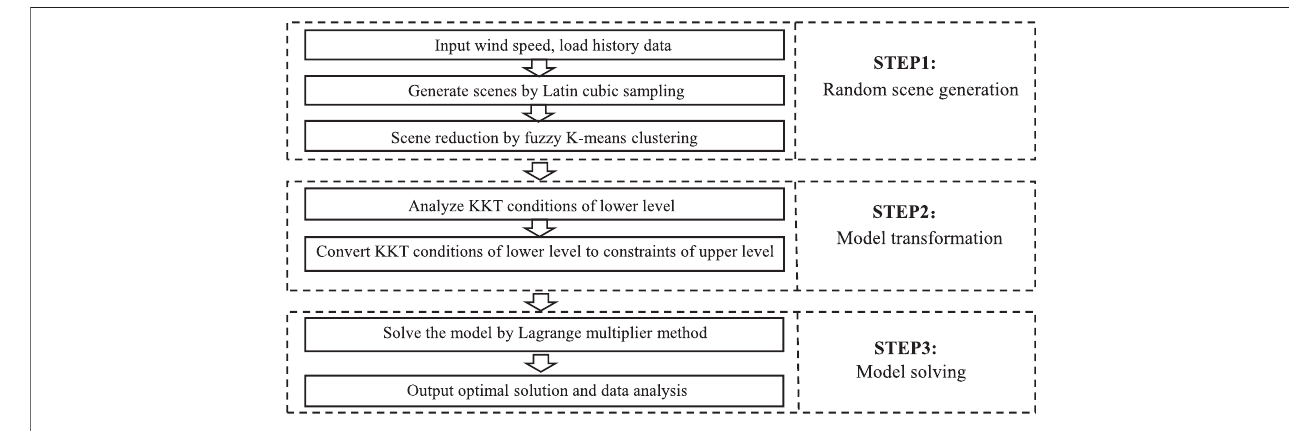
FIGURE 4 | Solving process.